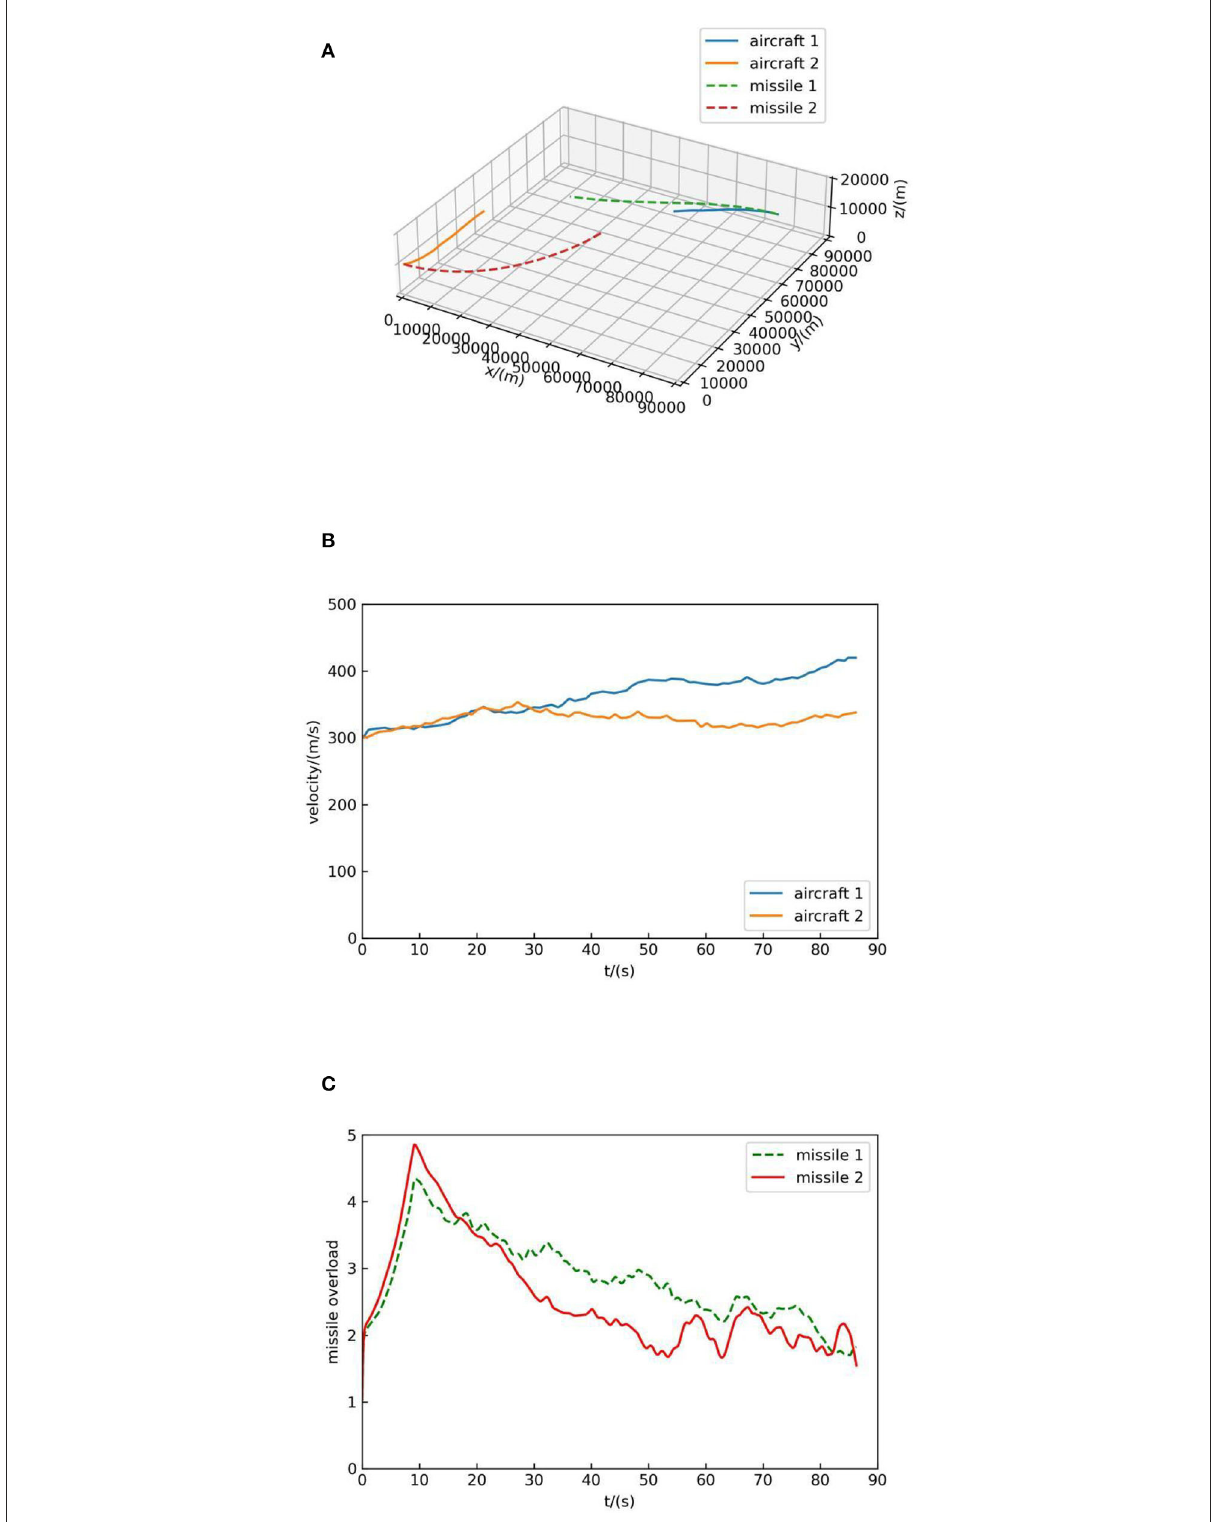
FIGURE9 Simulation result 3. (A) Air combat trajectory. (B) Velocity. (C) Missile